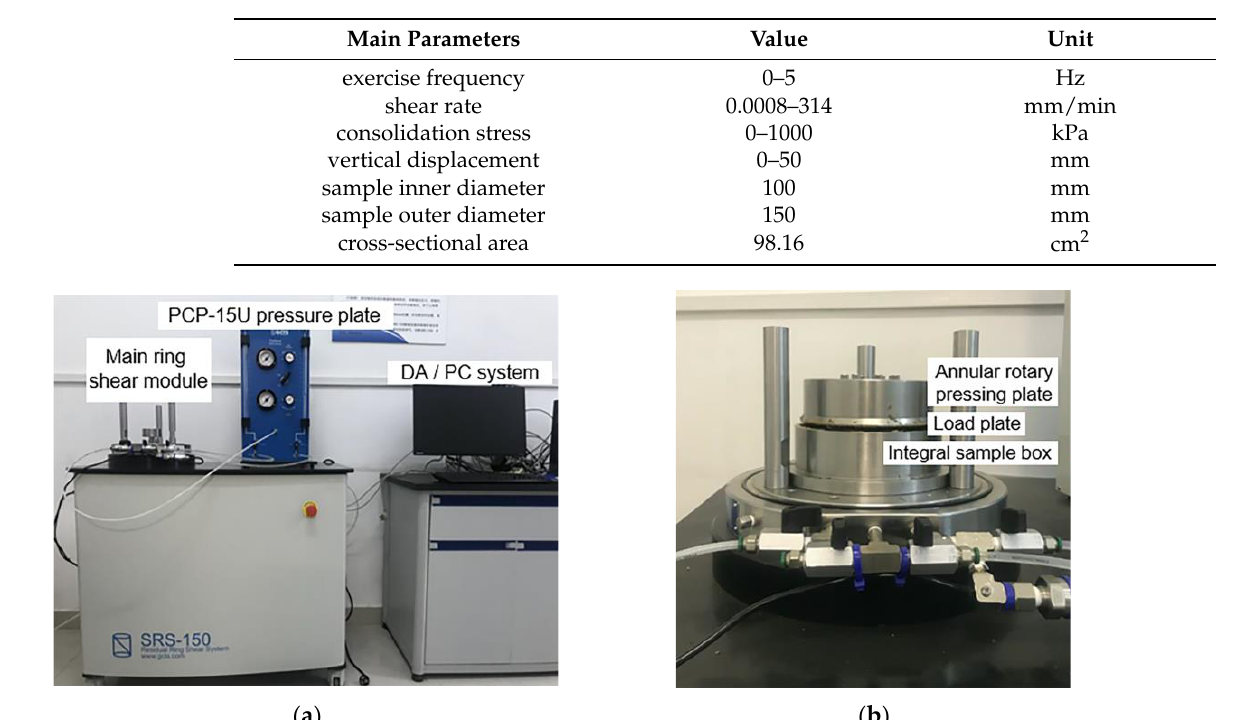
Table 1. Main parameters of SRS-150 test device.